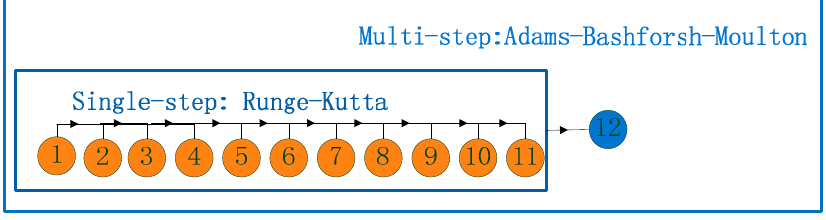
Figure 3. Implementation of the numerical integrator for orbit prediction.